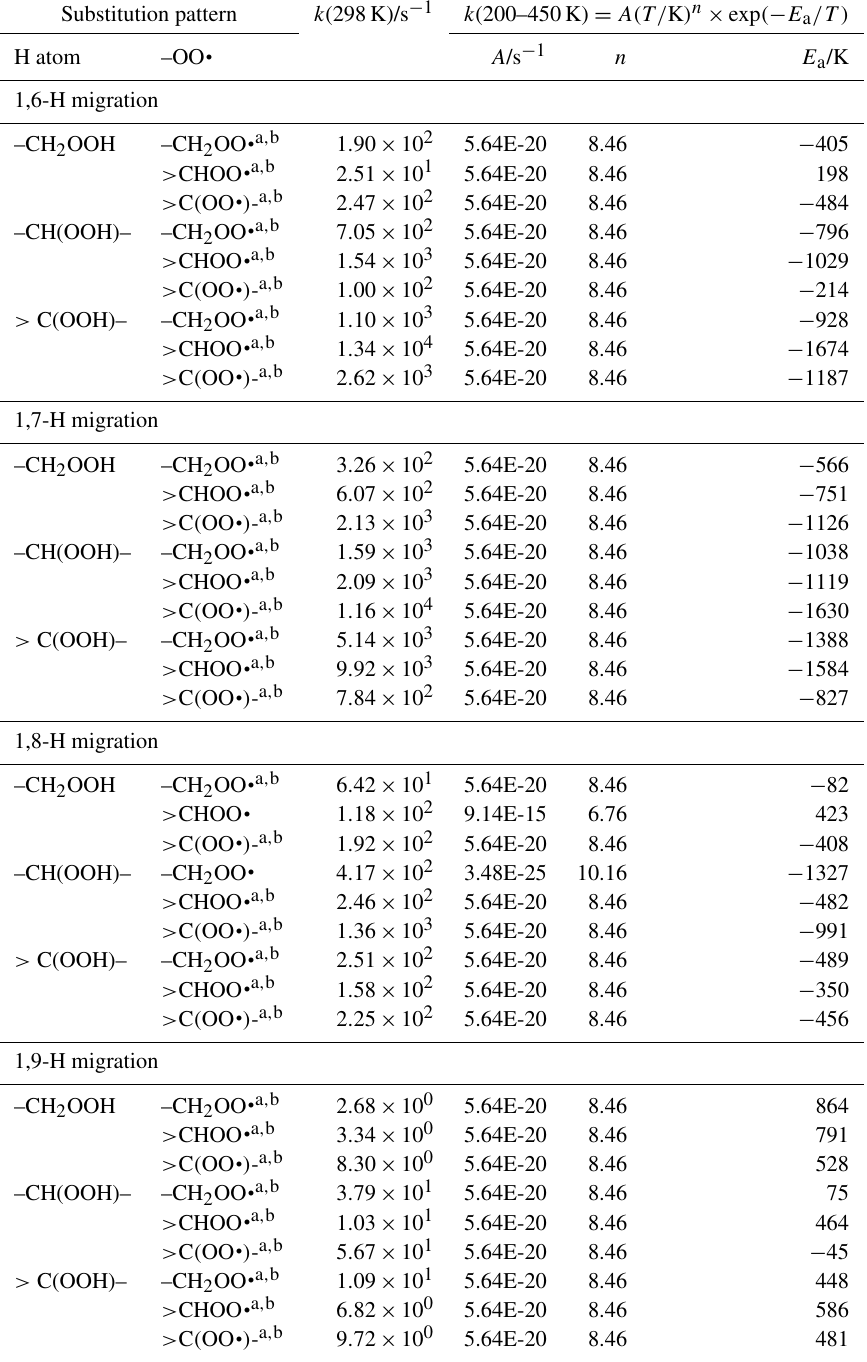
Table 8. Rate coefficients for H migration between –OOH groups and peroxy radicals. Substitution